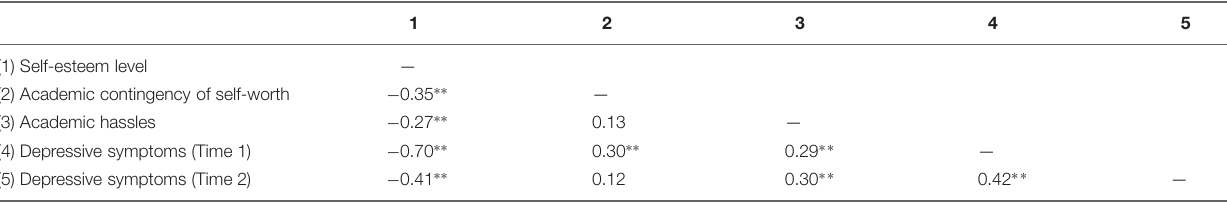
TABLE 4 | Correlations between SE level, aCSE, academic hassles, and DS.